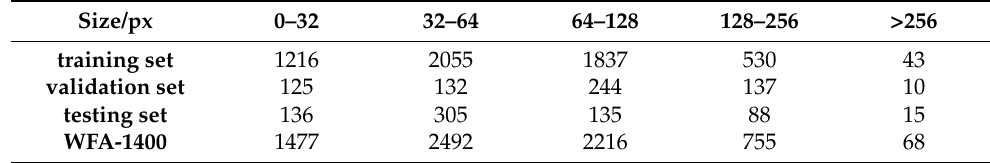
Table 1. Aircraft size distribution on